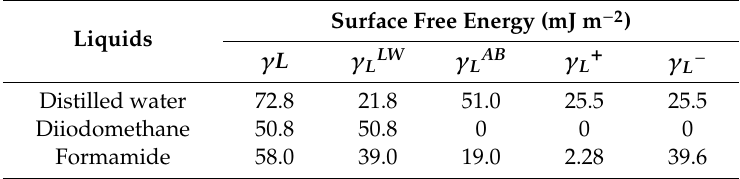
Table 1. Surface tension and components of three di ff erent test